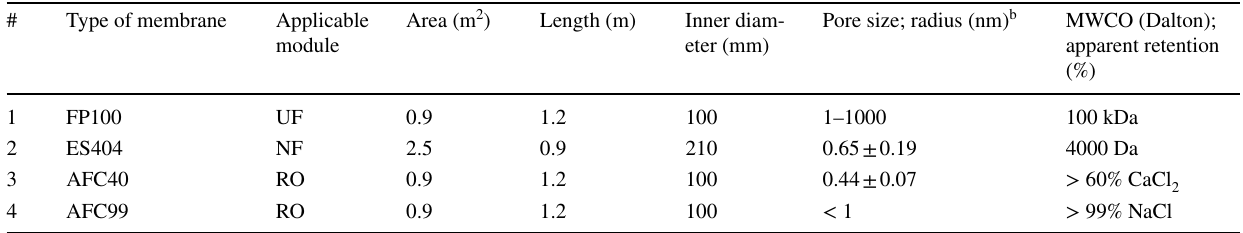
a Retention depends on several parameters, including nature of the test solution. This information should therefore be used as a guide only. Appli- cable module, area, length, diameter and MWCO were obtained from ITT PCI Membranes Ltd manuals b Pore size info were obtained from the other two mentioned sources in the table Table 7 Characteristics and specifications of the four commercial membrane types